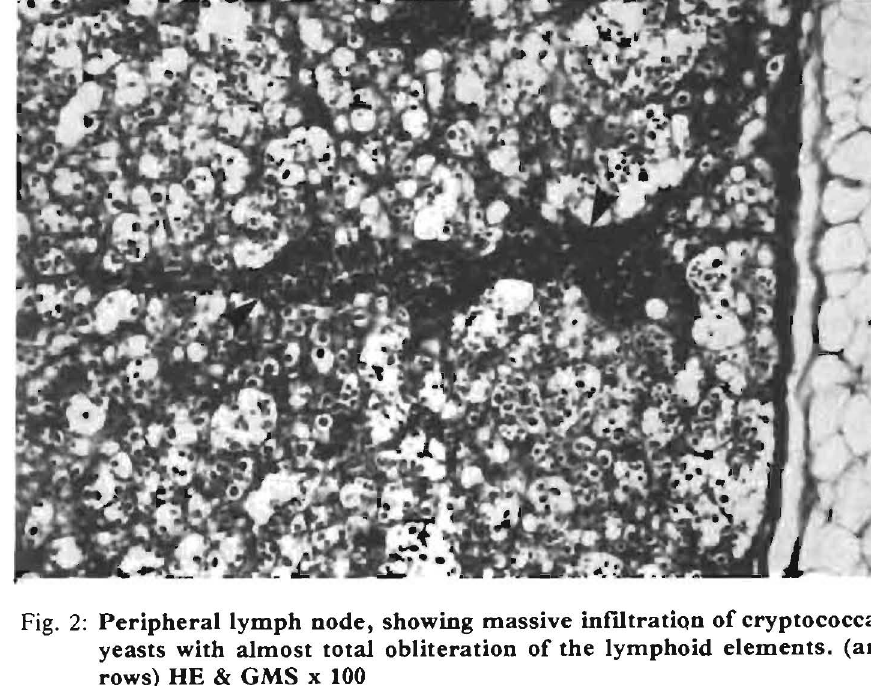
Fig. 2: Peripheral lymph Dode, showing massive inftltratiQD of cryptococcal yeasts with almost total obliteration of the lymphoid elements. (ar rows) HE & GMS x 100